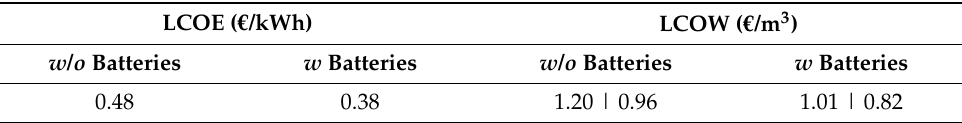
Table 6. LCOE ( € /kWh) and LCOW ( € /m 3 ) analysis (left/right values correspond to SEC = 1.0 and 0.5 kWh/m 3 , respectively) for SMGT technology in Antofagasta, Chile. LCOE ( € /kWh) LCOW ( € /m 3 ) w / o Batteries w Batteries w / o